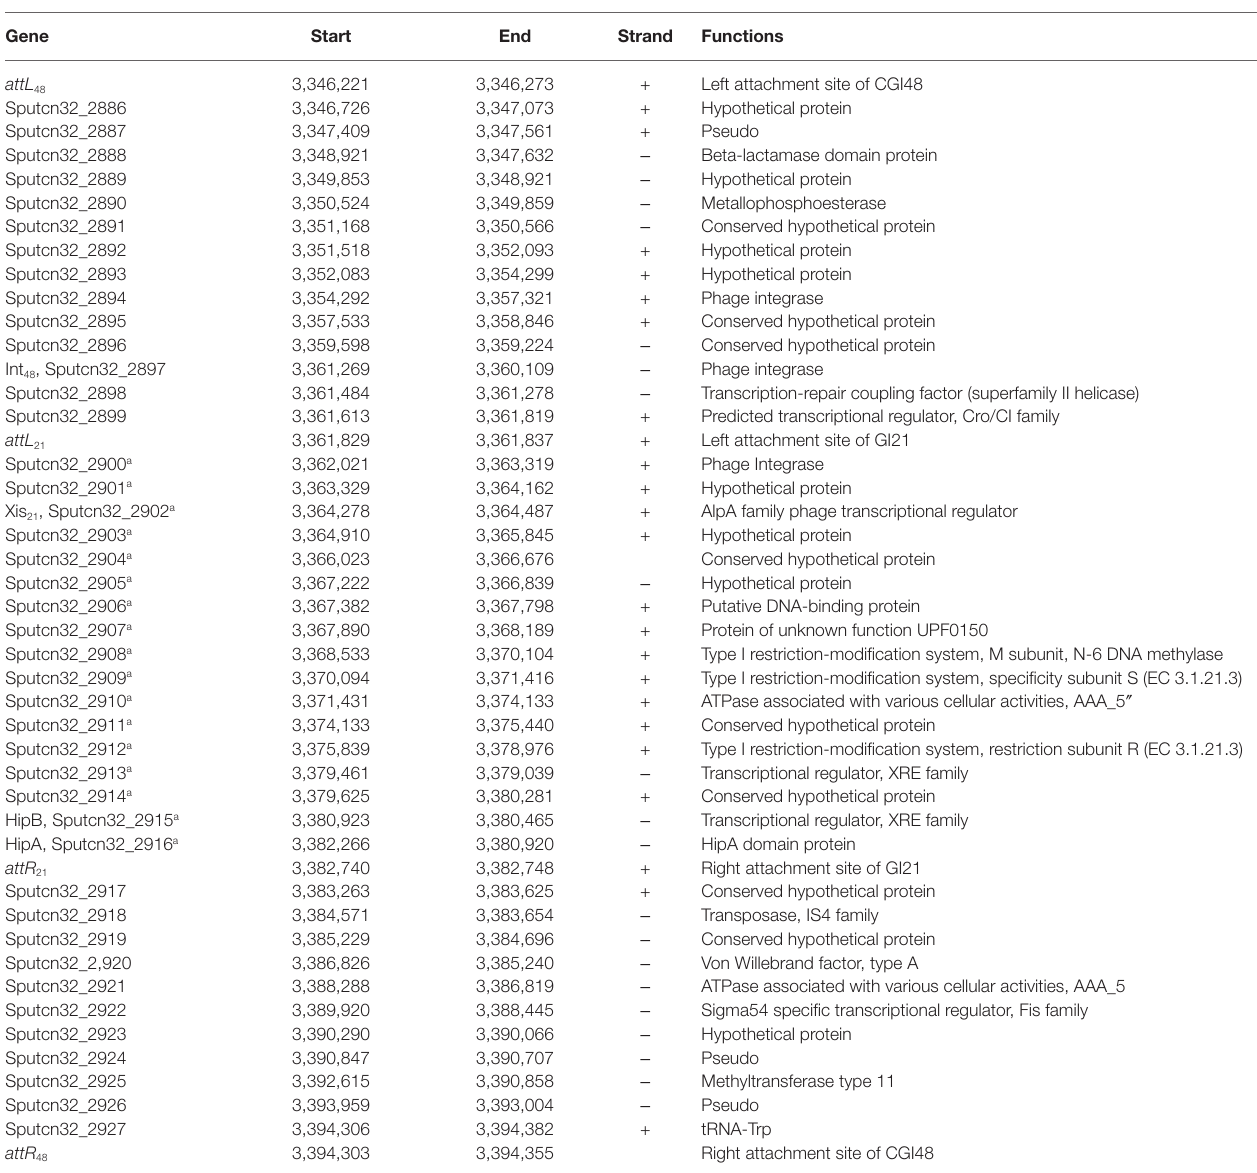
TABLE 3 | Sequence analysis of composite island CGI48. Gene Start End Strand Functions attL